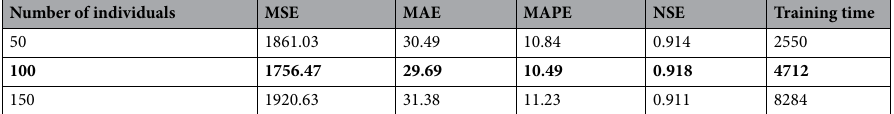
Table 3. Impact of number of individuals per generation. Best results are highlighted in bold text. The setting with ten individuals per generation achieves the best